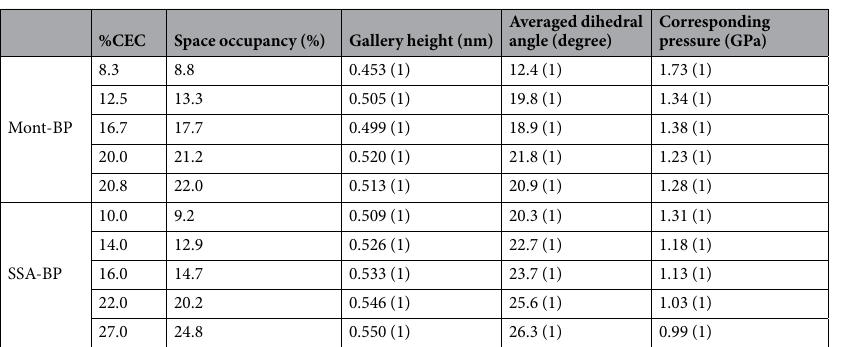
%CEC Space occupancy (%) Gallery height (nm)